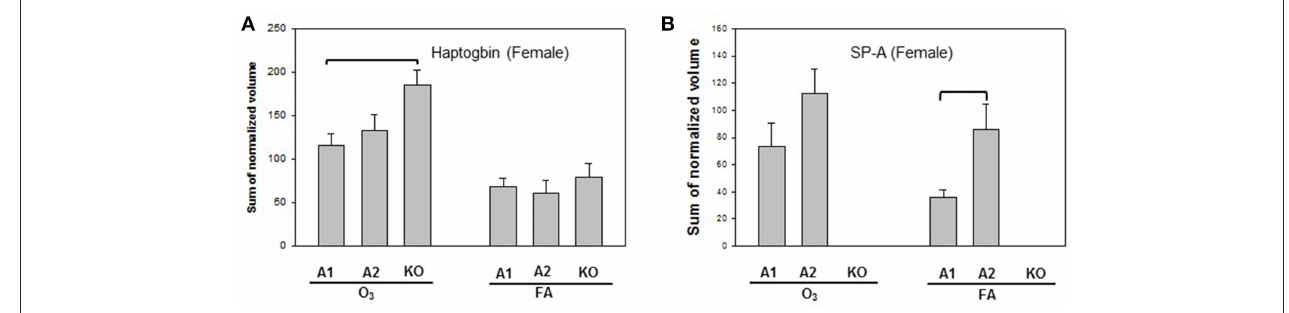
FIGURE 3 | Representative graphs of significant protein changes among genotypes in female mice. Two proteins (haptoglobin and SP-A) exhibit significant differences in comparisons among SP-A genotypes of female mice after exposure to ozone (O 3 ) or filtered air (FA). Histograms depicting levels of each specific protein are shown in (A) (Haptoglobin) and (B) (SP-A). Comparisons between groups that were statistically significant ( p < 0.05) are indicated with a bracket.